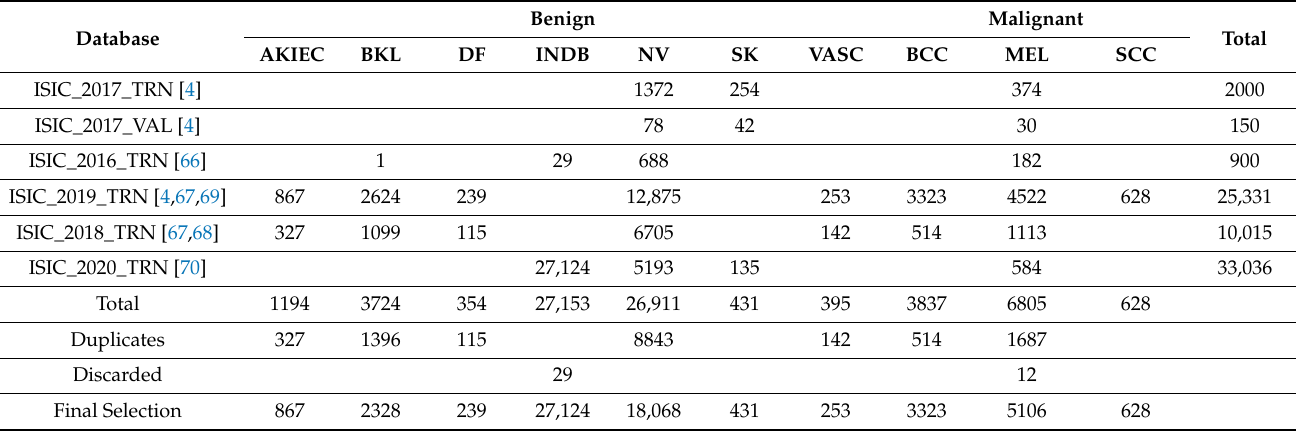
Table 2. Experimental datasets for training and validation.